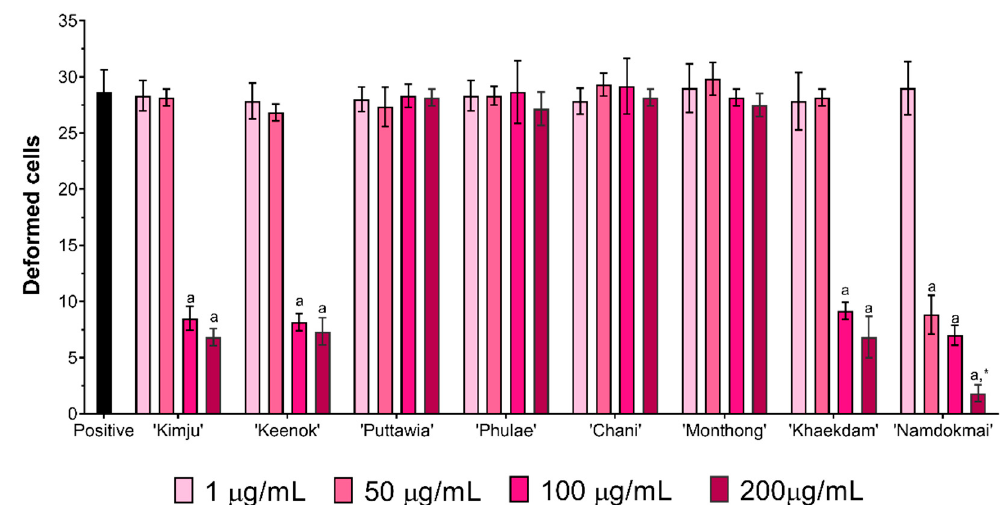
Figure 3. Effect of the eight fruit extracts on deformation of Raji cells after exposure to TPA and sodium butyrate. Numbers of deformed cells were counted from a total of 500 cells. Different lower case letters indicate significant differences ( p < 0.05) between each concentration of the extract compared to the positive control. The asterisk (*) indicates the significance of this dose within Mangifera indica ‘Namdokmai’. Error bars represent standard deviations (SD) from four experiments.